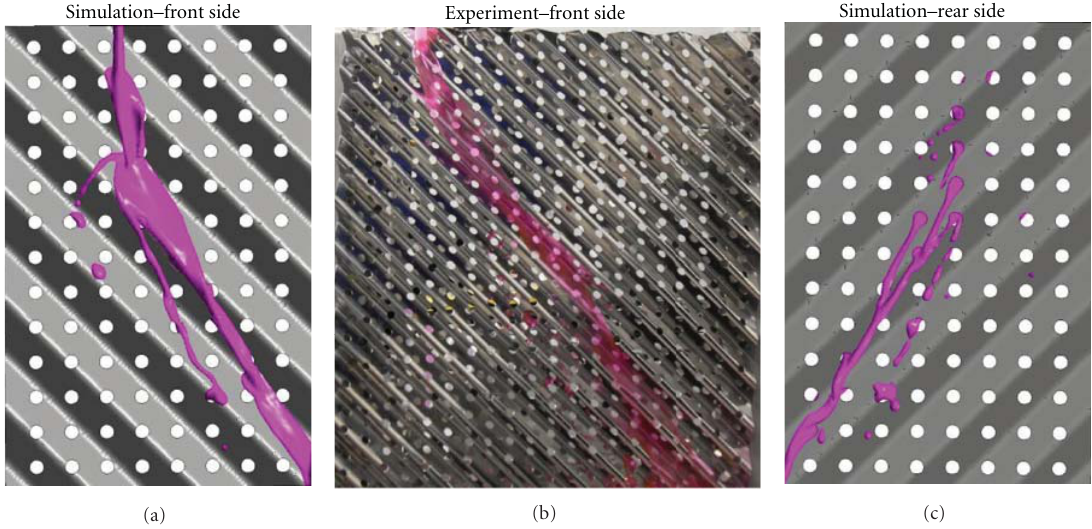
Figure 12: Comparison between simulation and experiment for flow of water on corrugated sheet of packing with perforations. Flow rate: